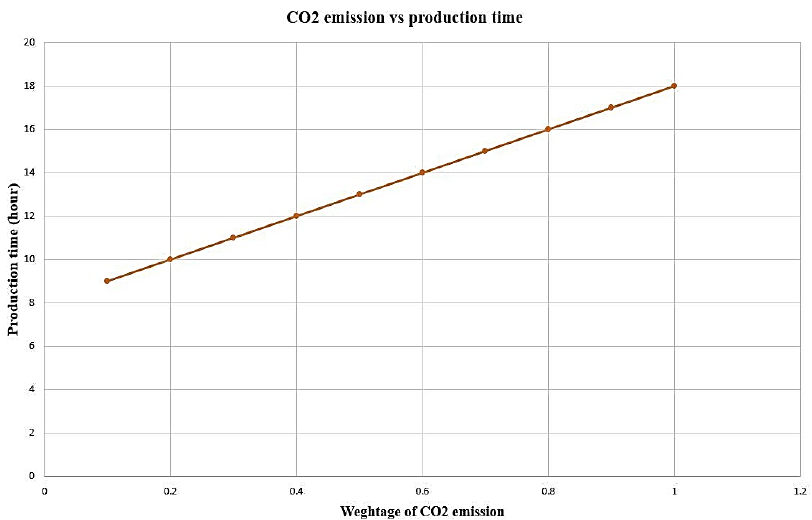
Fig. 5. CO2 emission vs. production time